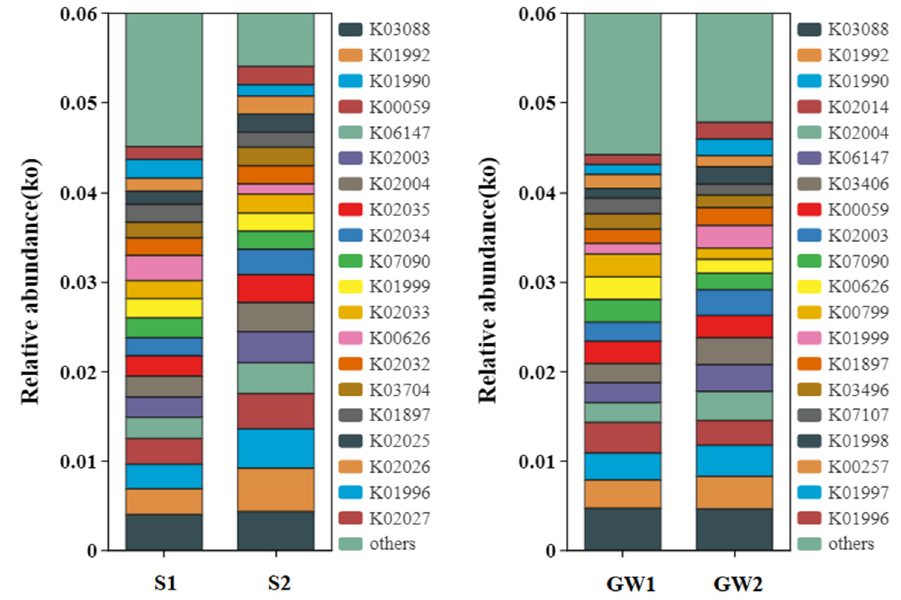
Figure 4. KEGG functional prediction at ko level for the samples (S indicates soil, and GW indi- cates groundwater).